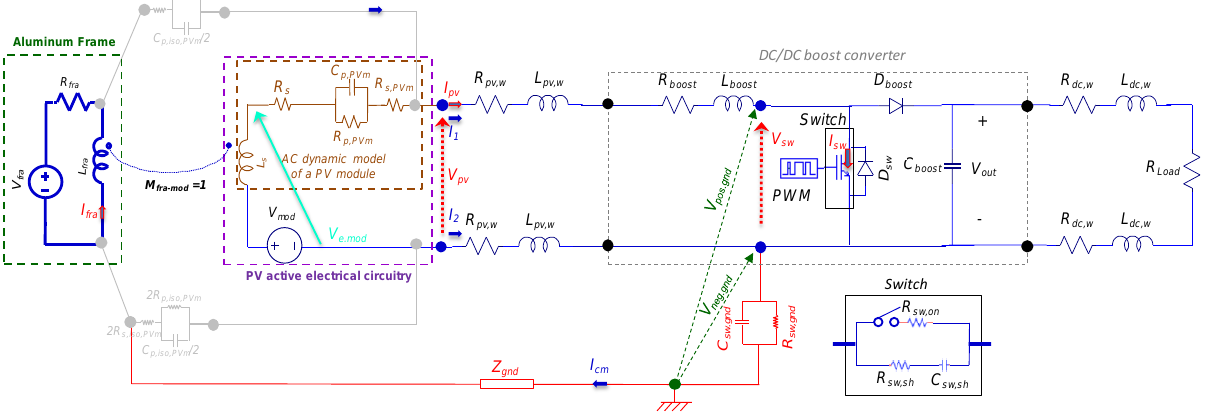
Figure 10. Full circuitry model for PV module and DC/DC converter assembly.